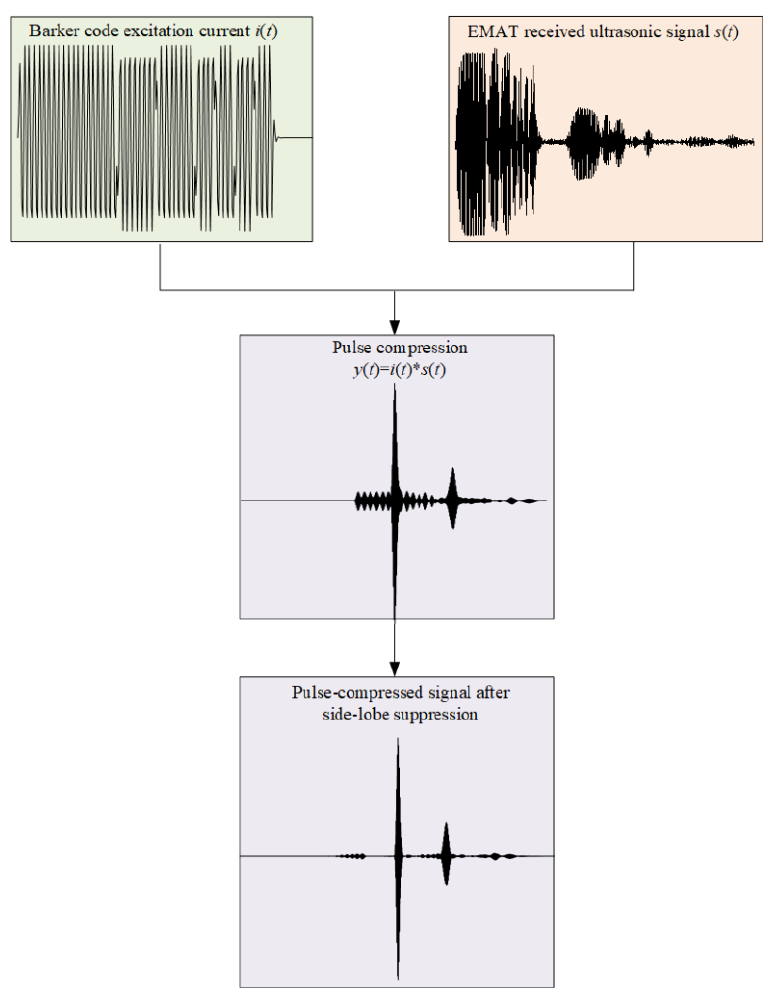
Figure 17. Barker code pulse compression technique implementation process.